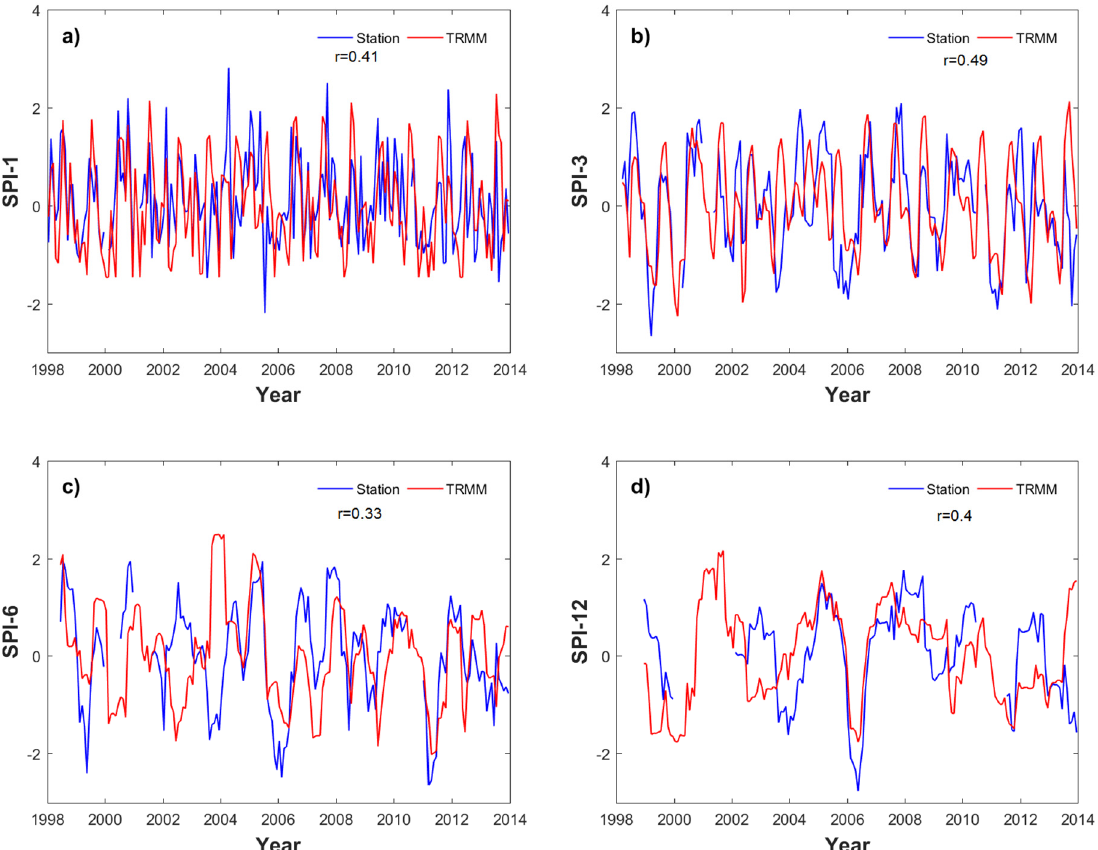
Figure 6. Comparison of SPI time series (TRMM-derived, blue line; Rain gauge derived, red line) at an arid climate (Sonora state in the north of Mexico) for different timescales: one month ( a ); three months ( b ); six months ( c ); and twelve months ( d ). Pearson’s r correlation coefficient depicts the statistical agreement between both datasets.